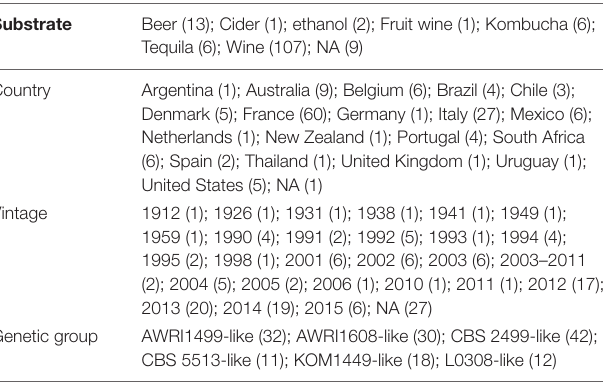
TABLE 1 | Summary of the collection of 145 Brettanomyces bruxellensis strains used for sulfur dioxide tolerance